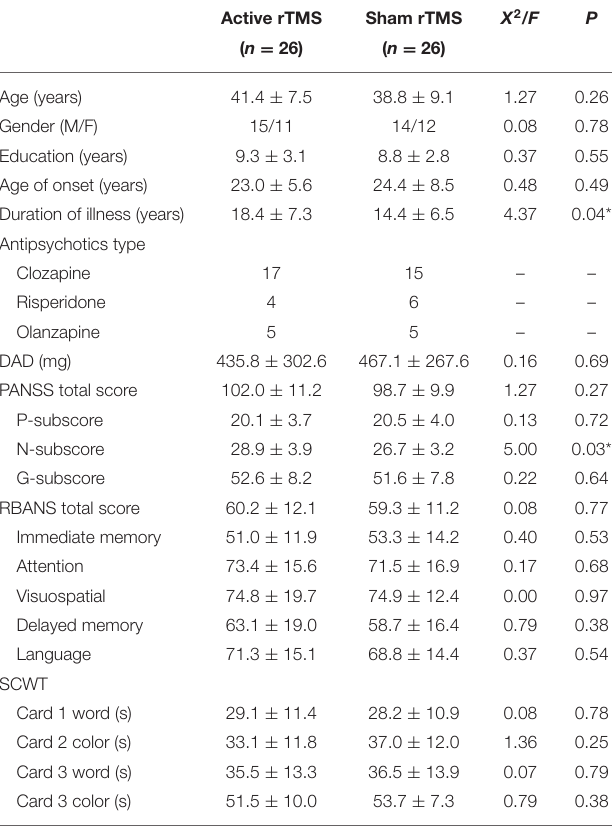
TABLE 1 | Baseline socio-demographics and clinical characteristics between groups of active rTMS and sham